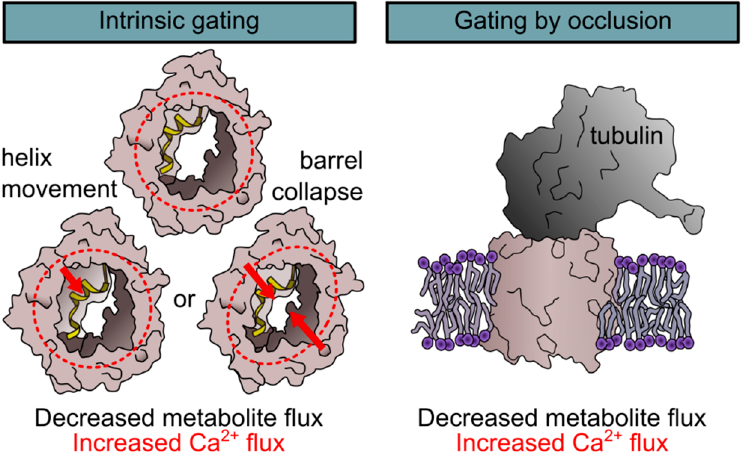
Figure 1. Mechanisms of voltage-dependent anion channels (VDAC) gating. Two mechanisms for the gating of VDACs were described, namely gating by an intrinsic conformational change (left) and gating by occlusion (right). The first is experimentally induced by voltage but is modulated by extrinsic parameters such as protein interactions, the lipidic environment or posttranslational modifications. Intrinsic gating results in a conformational change of a yet unknown nature. Several models ranging from a movement of the N-terminal α -helix to a collapse of the barrel were suggested. The second mechanism that was observed for VDAC gating is gating by occlusion by, e.g., free tubulin through a molecular plug model. Both mechanisms were shown to block metabolite flux and to induce a lower anion selectivity and, thus, an increased Ca 2+ flux.